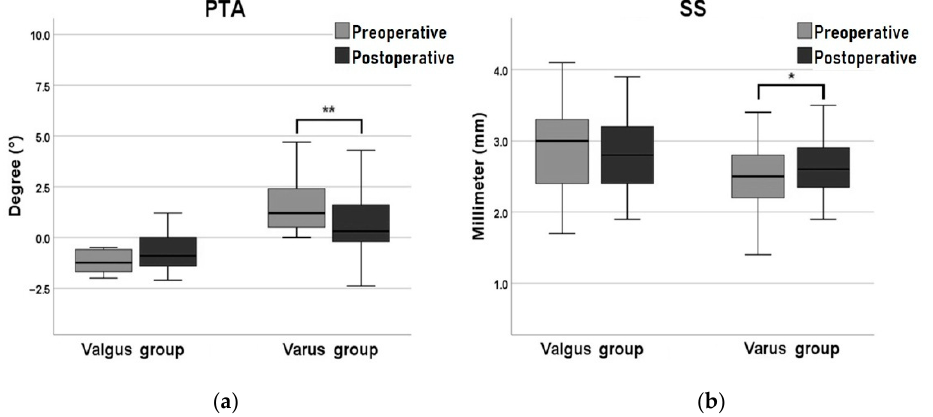
Figure 2. Post-TKA changes in ( a ) tibial plafond–talus angle (PTA) and ( b ) superior space (SS). ** p < 0.01, * p <